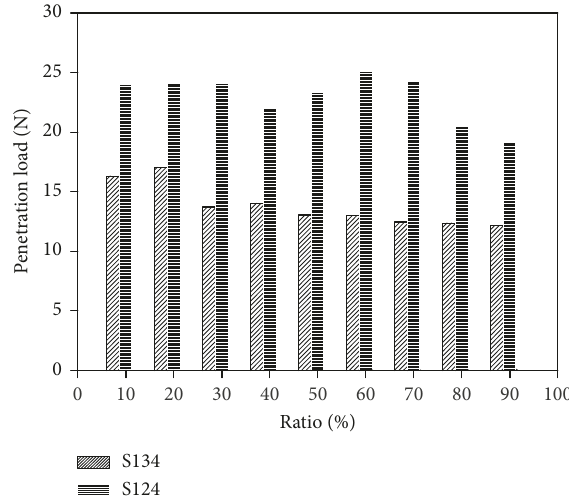
Figure 12: Penetration loads of two kinds of three-aggregate mixtures with gap gradation at the penetration displacement of 6mm.